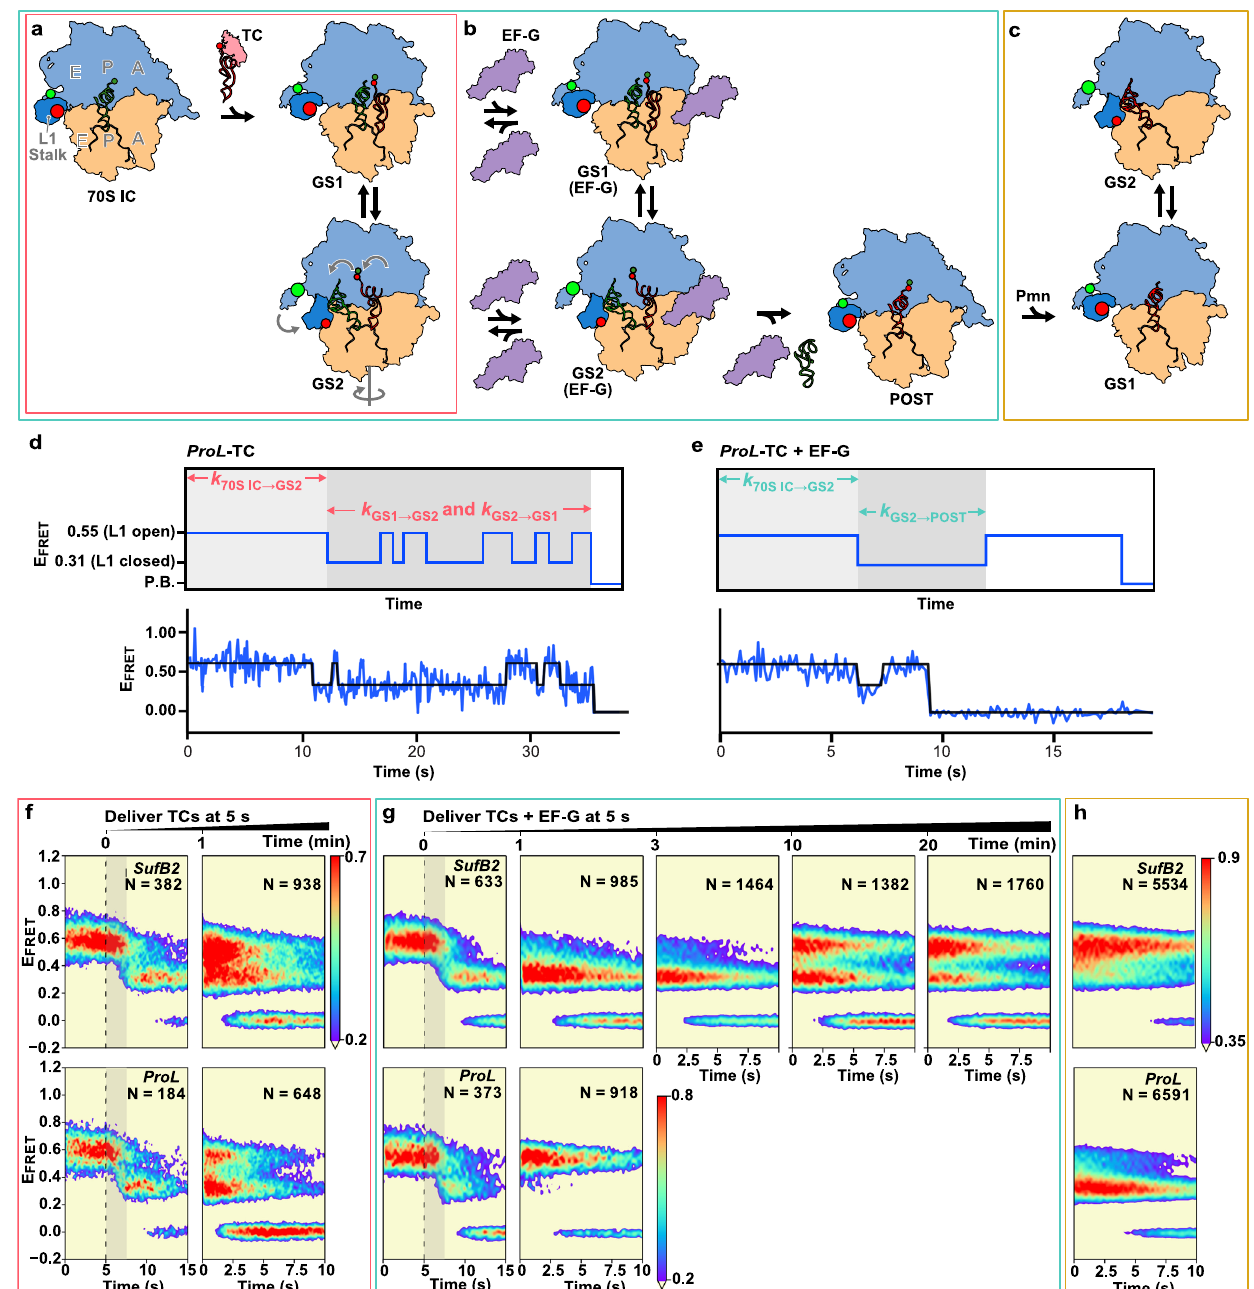
Fig. 6 SufB2 interferes with elongation complex dynamics during late steps of translocation. a – c Cartoon representation of elongation as a G37-state SufB2 - or ProL -TC is delivered to the A site of a bL9(Cy3)- and uL1(Cy5)-labeled 70 S IC; a in the absence, or b in the presence of EF-G, or c upon using puromycin (Pmn) to deacylate the P site-bound G37-state SufB2 or ProL and generate the corresponding PRE – A complex. The 30S and 50S subunits are tan and light blue, respectively; the L1 stalk is dark blue; Cy3 and Cy5 are bright green and red spheres, respectively; EF-Tu is pink; EF-G is purple; fMet- tRNA fMet is dark green; and SufB2 or ProL is dark red. d , e Hypothetical (top) and representative experimentally observed (bottom) E FRET vs. time trajectories recorded as ProL -TC is delivered to a 70S IC, d in the absence and e in the presence of EF-G as depicted in ( a , b ). The waiting times associated with k 70S IC → GS2 , k GS1 → GS2 , k GS2 → GS1 , and k GS2 → POST are indicated in each hypothetical trajectory. f – h Surface contour plots of the time evolution of population FRET obtained by superimposing individual E FRET vs. time trajectories in the experiments in ( a – c ), respectively, for SufB2 (top) and ProL (bottom). N: the number of trajectories used to construct each contour plot. Surface contours are colored as denoted in the population color bars. For pre- steady-state experiments, the black dashed lines indicate the time at which the TC was delivered and the gray shaded areas denote the time required for the majority (54 – 68%) of the 70S ICs to transition to GS2. Note that the rate of deacylated SufB2 dissociation from the A site under our conditions is similar to that of EF-G-catalyzed translocation, thereby resulting in the buildup of a PRE complex sub-population over 3 – 20 min post-delivery that lacks an A site tRNA and is incapable of translocation. This sub-population exhibits k GS1 → GS2 , k GS2 → GS1 , and K eq values similar to those observed in experiments recorded in the absence of EF-G (Supplementary Table